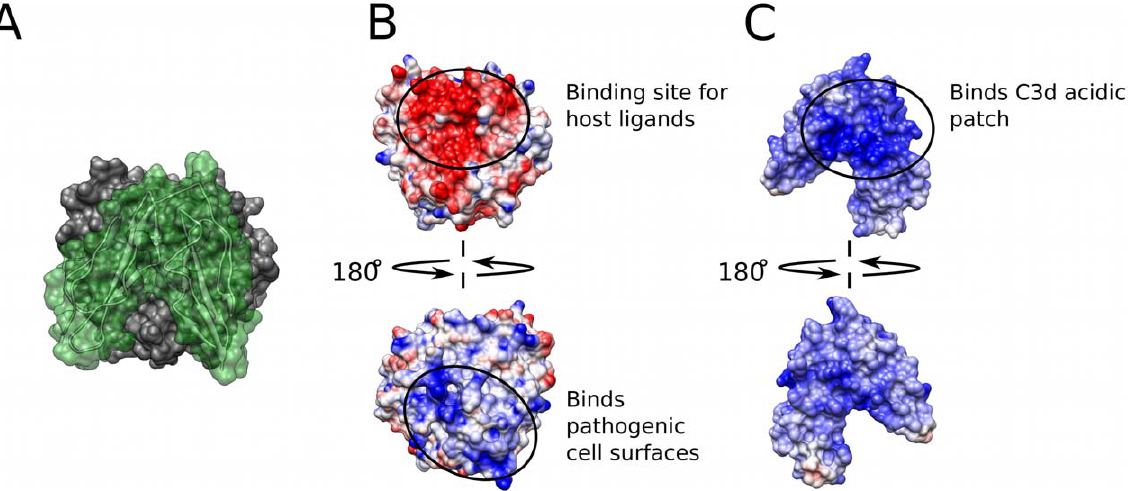
Figure 1. Molecular representations of the C3d-CR2 interaction. (A) Surface representation of the C3d-CR2 interaction with C3d in gray and CR2 in green (PDB Code: 3OED). (B) Electrostatic potential surface projection for C3d (PDB Code: 1C3D). (C) Electrostatic potential surface projection for CR2 (PDB Code: 1LY2). The code for panels (B) and (C) are as follows: the color transitions from red – white – blue when going from negative ( 2 5 kT/e) – neutral (0 kT/e) – positive ( + 5 kT/e) electrostatic potential.